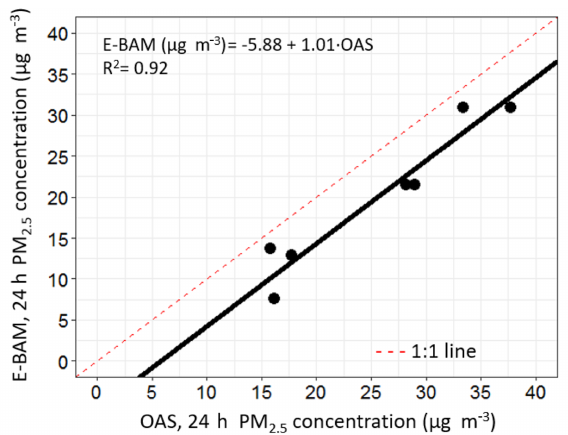
Figure 9. Performance of the Outdoor Aerosol Sampler relative to an E-BAM federal equivalent Monitor (meets US-EPA require- ments for Class III designation for PM 2 . 5 ) at location